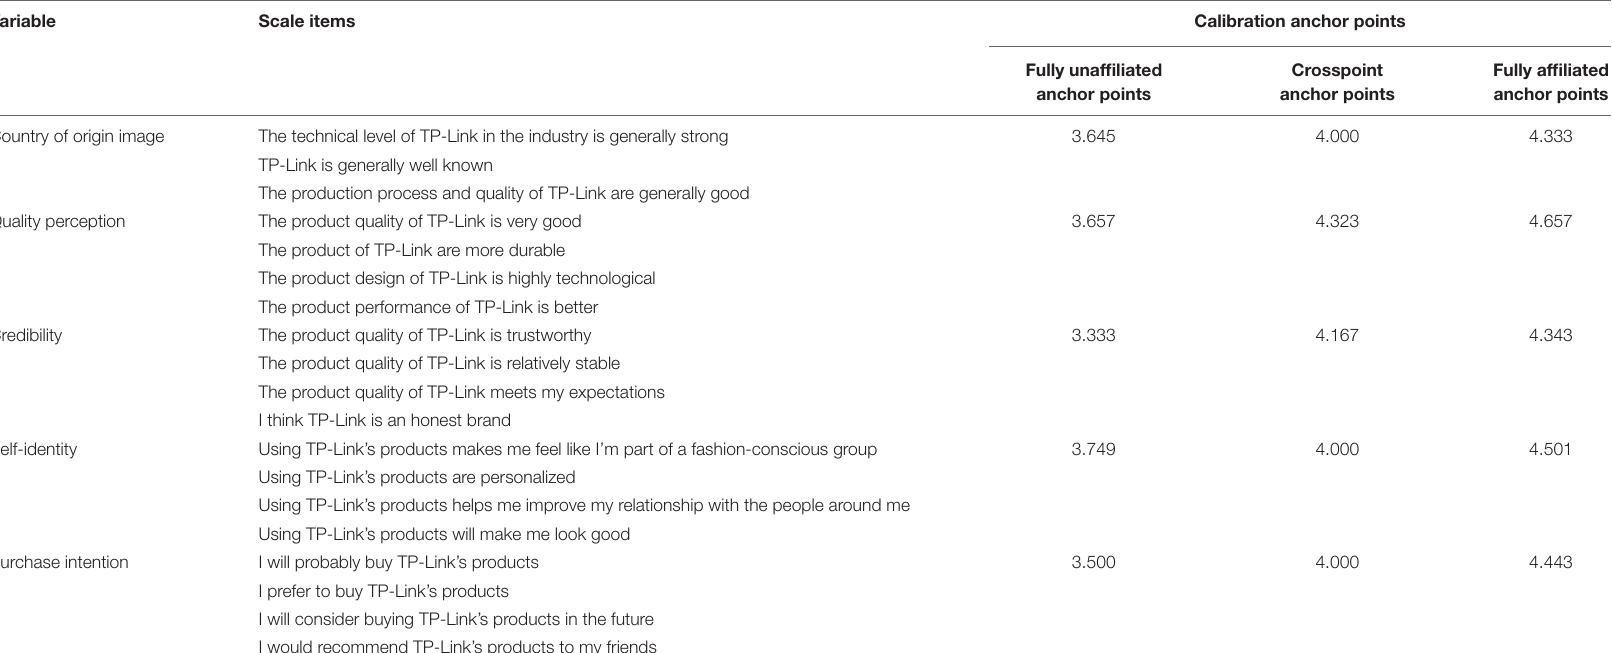
Fully unaffiliated Crosspoint Fully affiliated anchor points anchor points anchor points